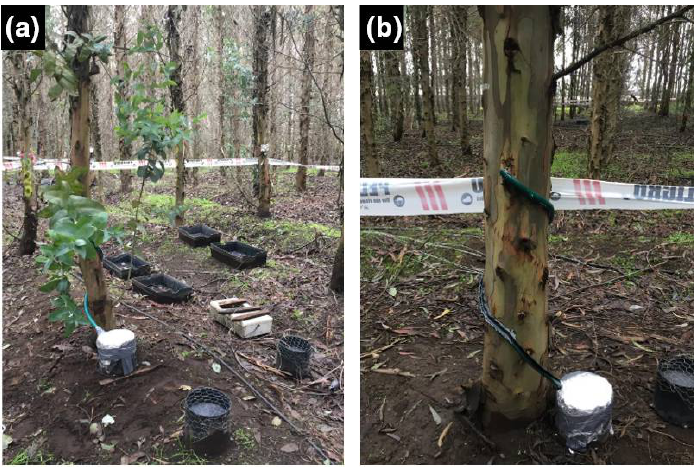
Figure 1. Example of rain gauge distribution for throughfall ( a ) and collection system for stemflow ( b ). For INT, Tf, and Sf, a set of linear equations were implemented; in the case of INT ratio, a logarithmic equation was considered; to evaluate differences in genotypes, the likelihood ratio test was used. Analysis was run in R version 4.1.2 and considered a p value < 0.05 as significant.